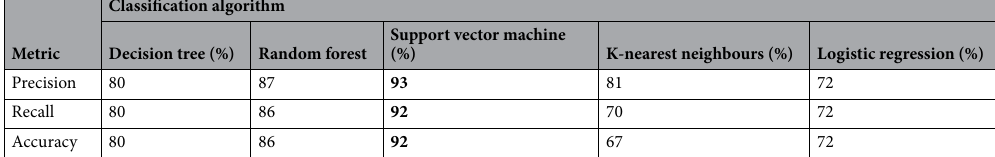
Table 2. Students’ performance prediction models based on 15-folds cross validation results. Top result values are in